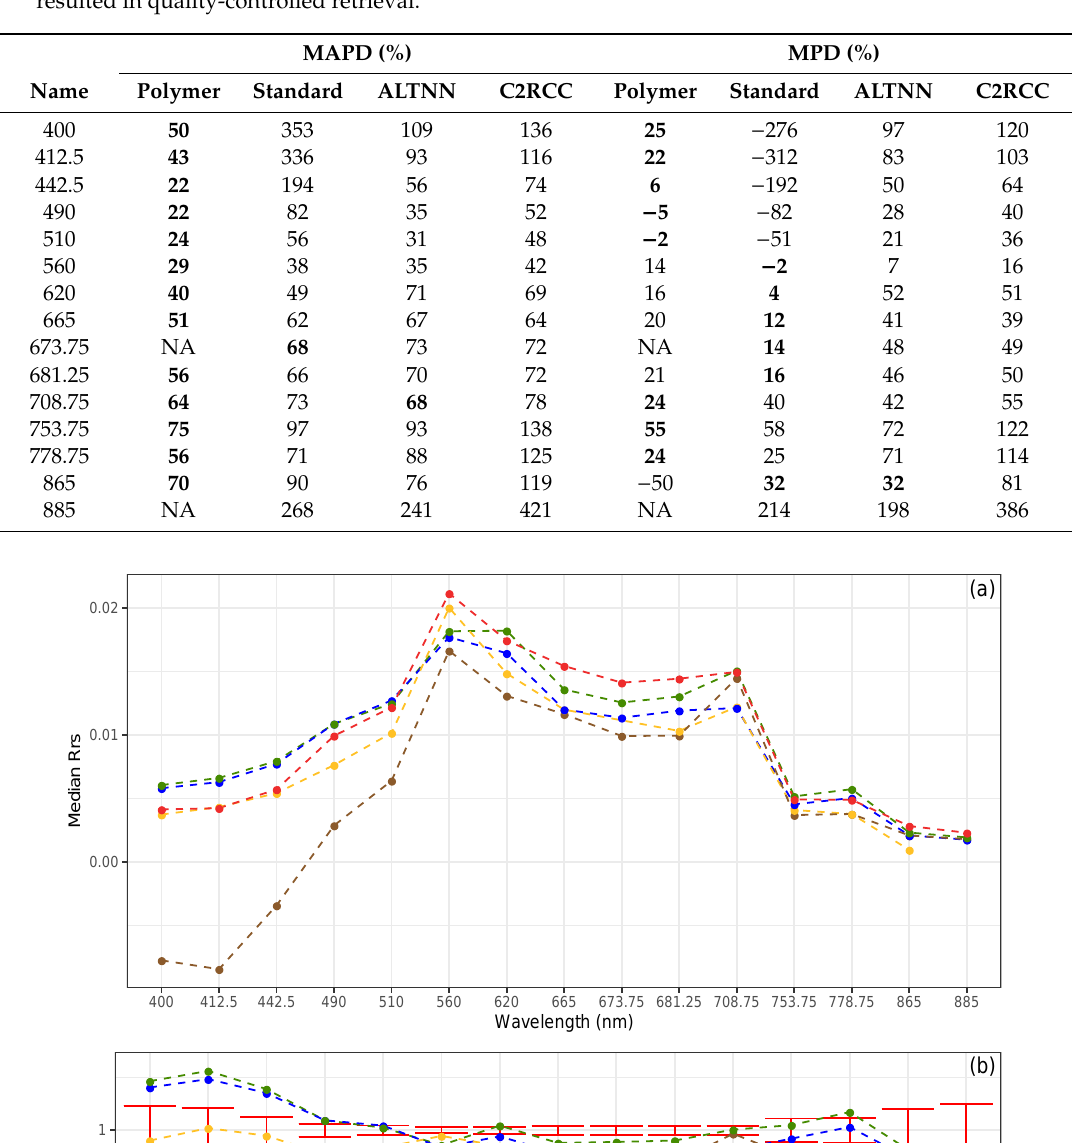
Table 1. This is a table caption. Tables should be placed in the main text near to the first time they are cited.